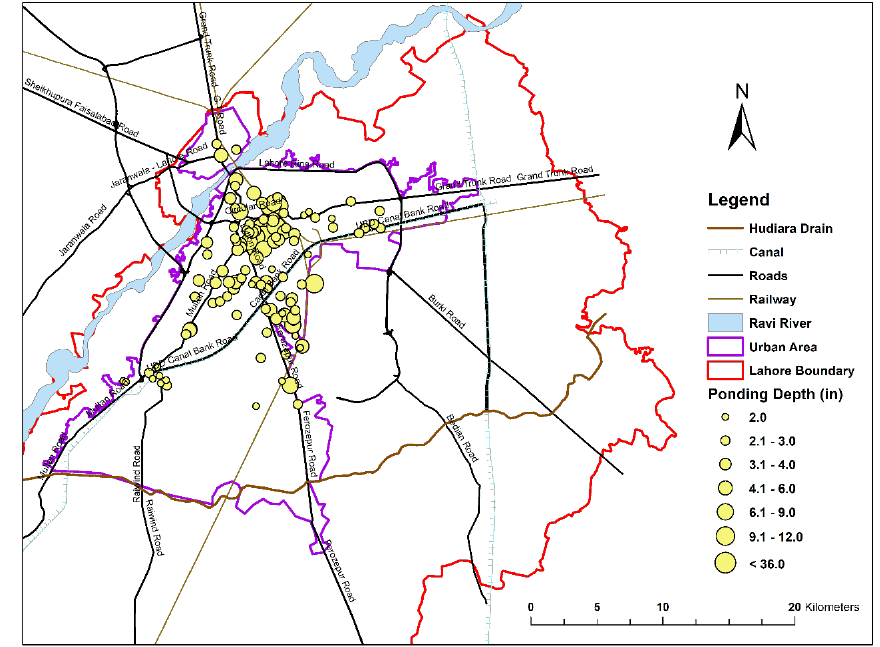
Figure 3. Location of ponding sites and ponding depth.